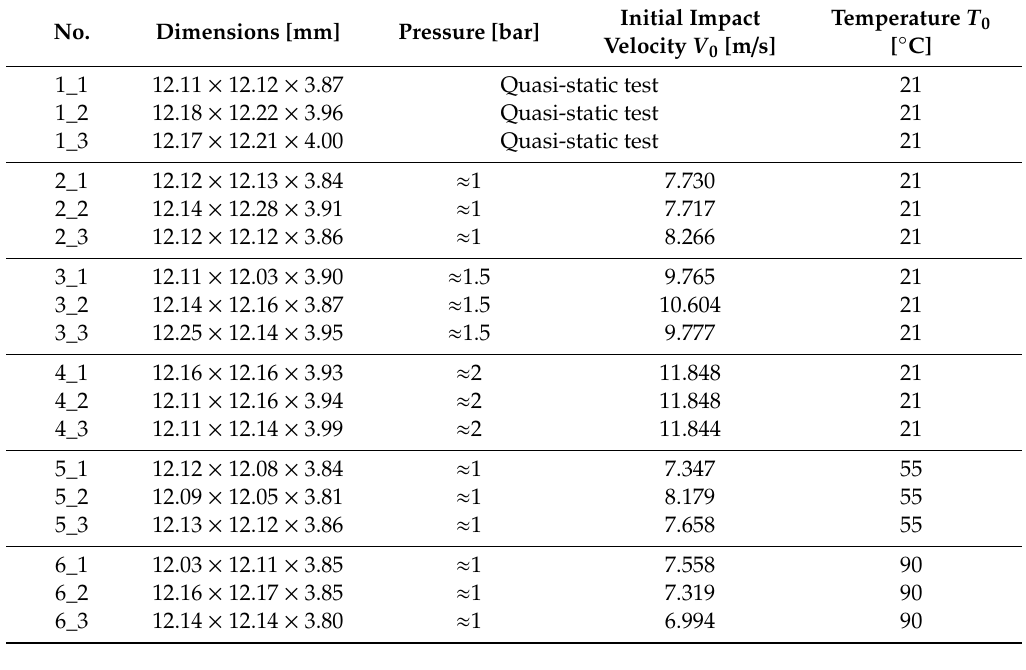
Table 1. Characteristics of laboratory test.